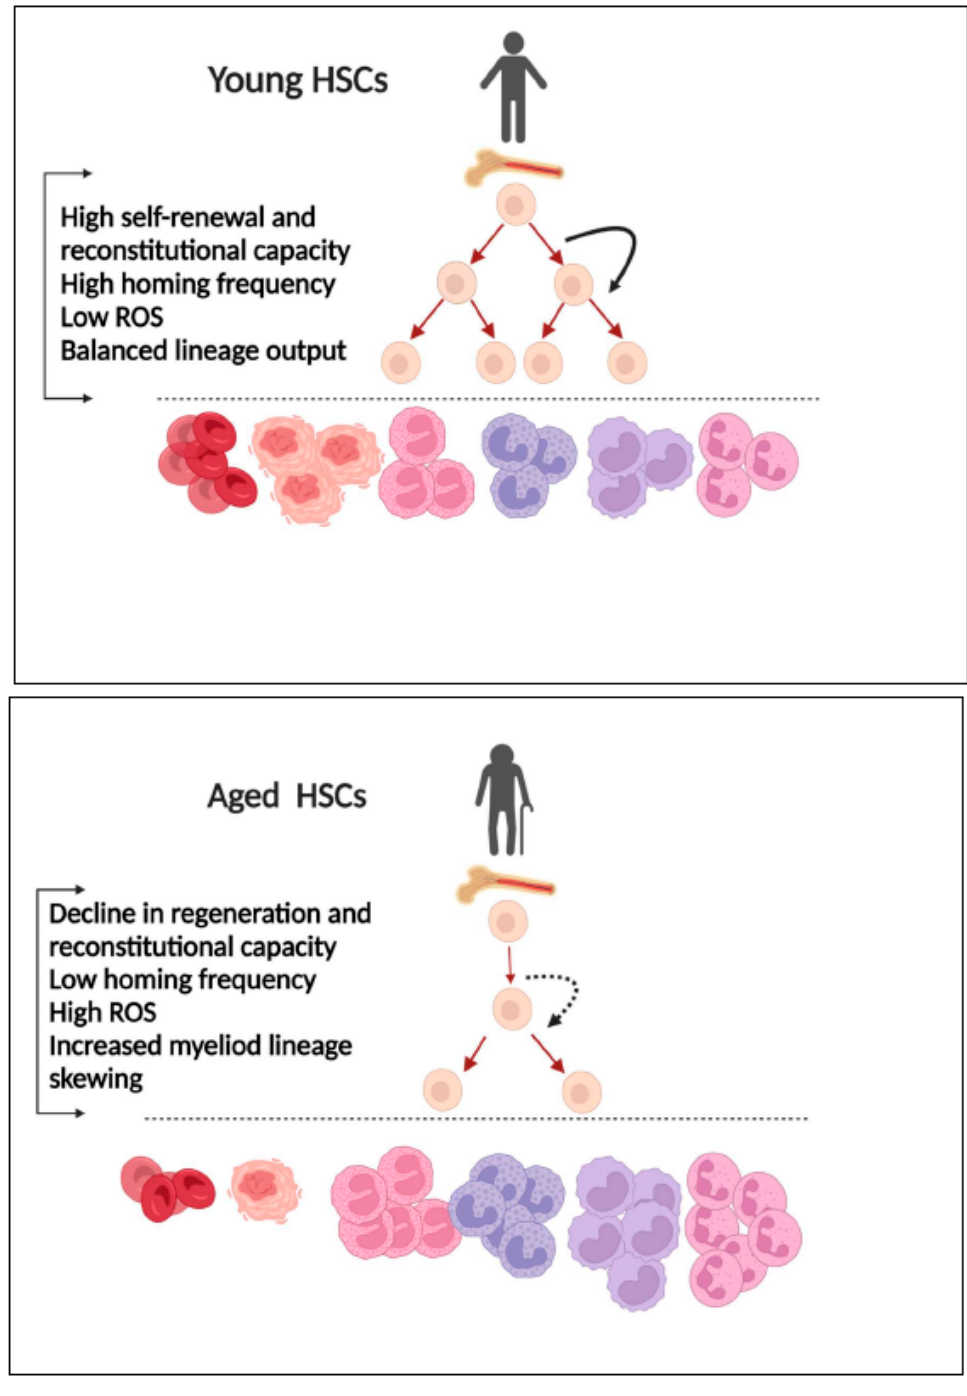
Figure 1. Ageing-associated changes in HSCs. Young HSCs exhibit high self-renewal and recon- stitutional capacities, a high homing frequency, low ROS, and a balanced lineage output. Aged HSCs are characterized by a decline in self-renewal and reconstitutional capacities, high ROS, a low homing frequency, and increased myeloid lineage skewing. Created with BioRender.com, accessed on 19 June